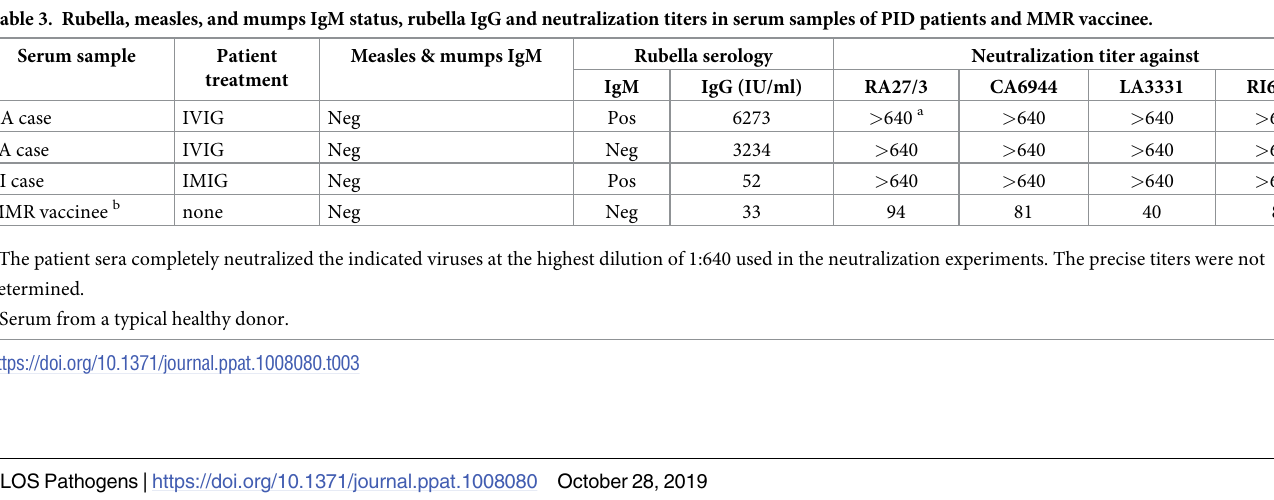
Table 3. Rubella, measles, and mumps IgM status, rubella IgG and neutralization titers in serum samples of PID patients and MMR vaccinee. Serum sample